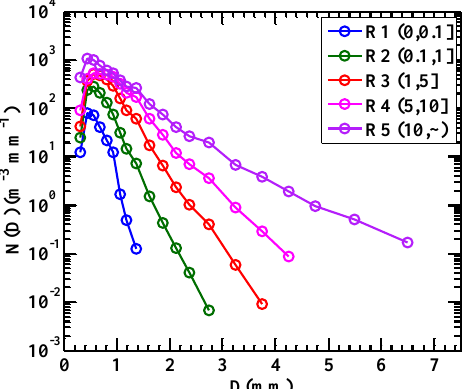
Figure 5. Averaged DSDs for the five indicated rainfall rates (R1–R5). The integral rainfall parameters derived from these averaged spectra are presented in Table 1. The circles represent the center of the Parsivel diameter classes. Table 1. Integral rainfall physical quantities derived from the averaged DSDs and the fitted gamma distribution parameters for the five rain-rate regimes .